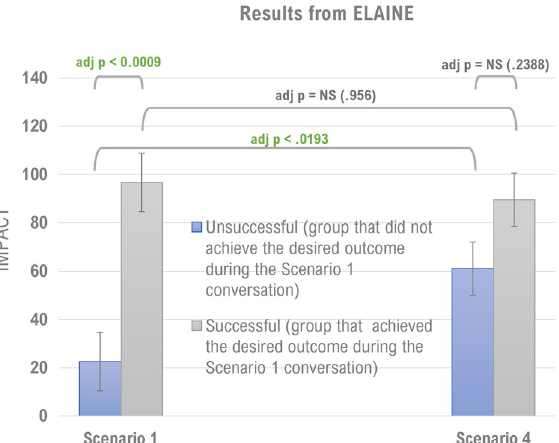
Figure 4. (Left): Individuals who were identified as having deficits after the baseline Scenario (Unsuccessful Group) showed a significant improvement by Scenario 4. A between group comparison reveals that the unsuccessful group after Scenario 1 showed no significant differences from the successful group after Scenario 4. The difference in interpersonal effectiveness for the Successful group between Scenario 1 and Scenario 4 was not